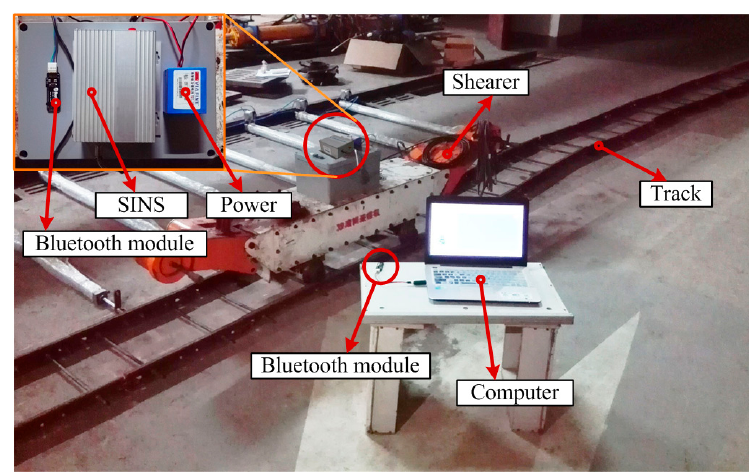
Figure 6. Experimental scene of the shearer for the SINS positioning system.